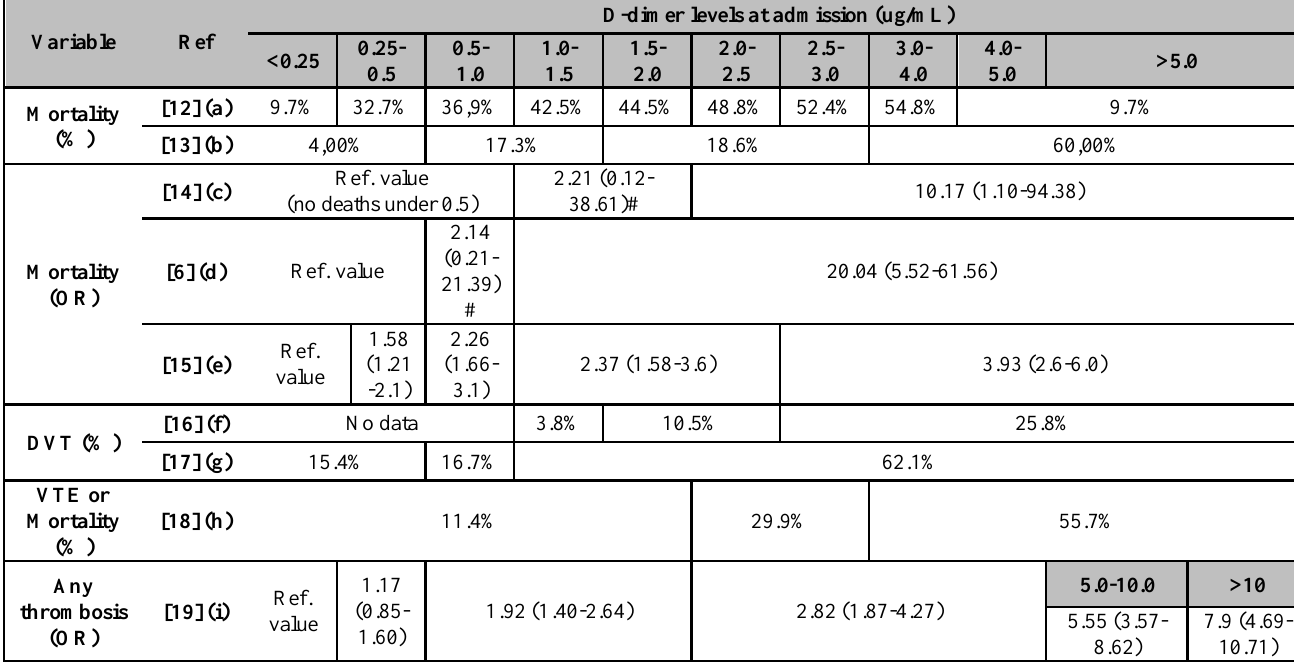
Table 1. Summarized data for mortality, DVT and VTE incidence, and odds ratio of mortality and any thrombotic event across